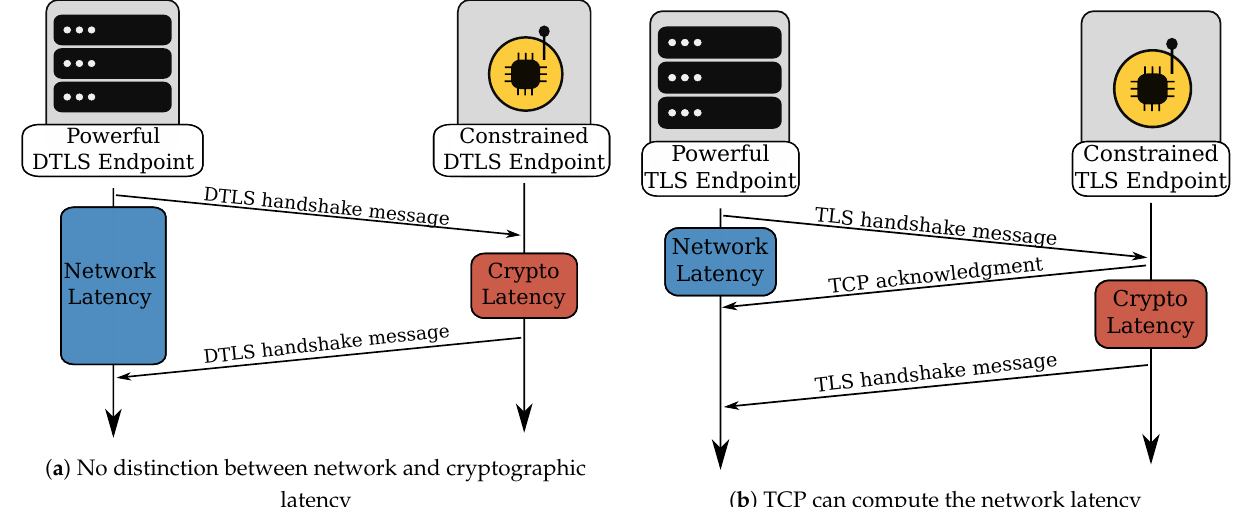
Figure 8. Computational-intensive computations can cause spurious retransmissions during the DTLS handshake. TCP’s acknowledgments indicate that the TCP segment arrived correctly and no retransmission is necessary, even if a reply is not immediately